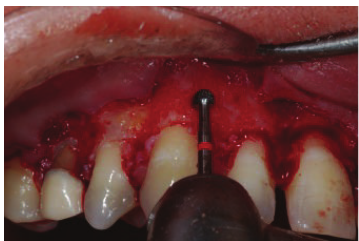
Figure 10: Bone tissue resection through rotating instrument.